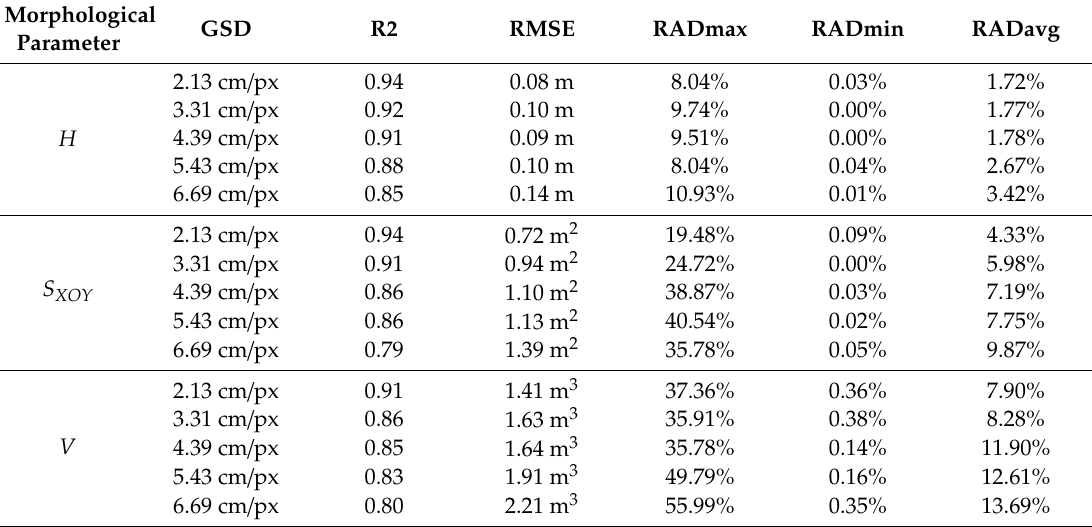
Table 4. Analysis of the measurement results of morphological characteristic parameters of the orchard